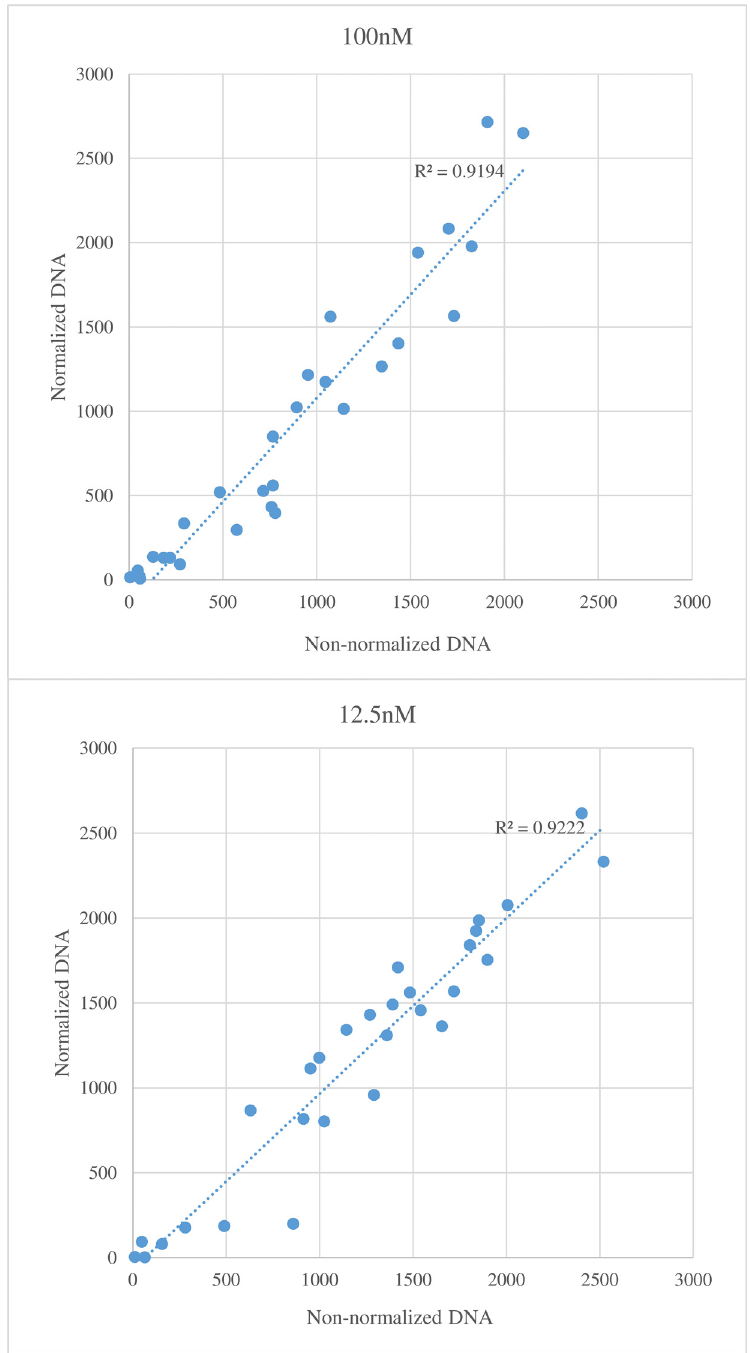
Fig 2. Average number of reads per marker analyzed using non-normalized (x-axis) and normalized (y-axis) DNA. The top figure used 100 nM primers for PCR and the bottom figure used 12.5 nM primers for